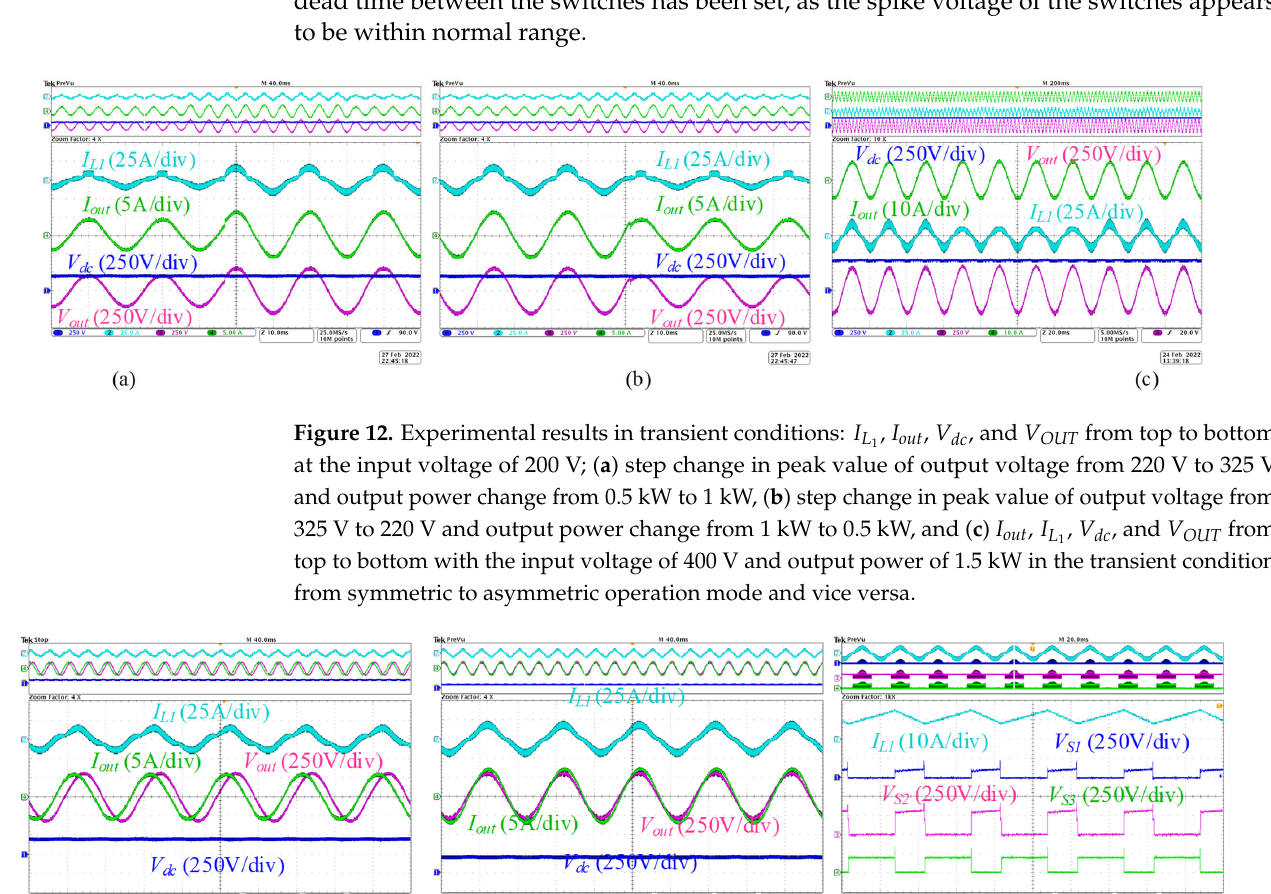
Figure 13. Experimental results in reactive power modes: I L , V OUT , I OUT , and V dc from top to bottom at input voltage of 200 V and output apparent power of 1 kVA; ( a ) with power factor of 0.7 leading, ( b ) with power factor of 0.96 lagging, and ( c ) voltage stress of the switches S 1 , S 2 , and S 3 .